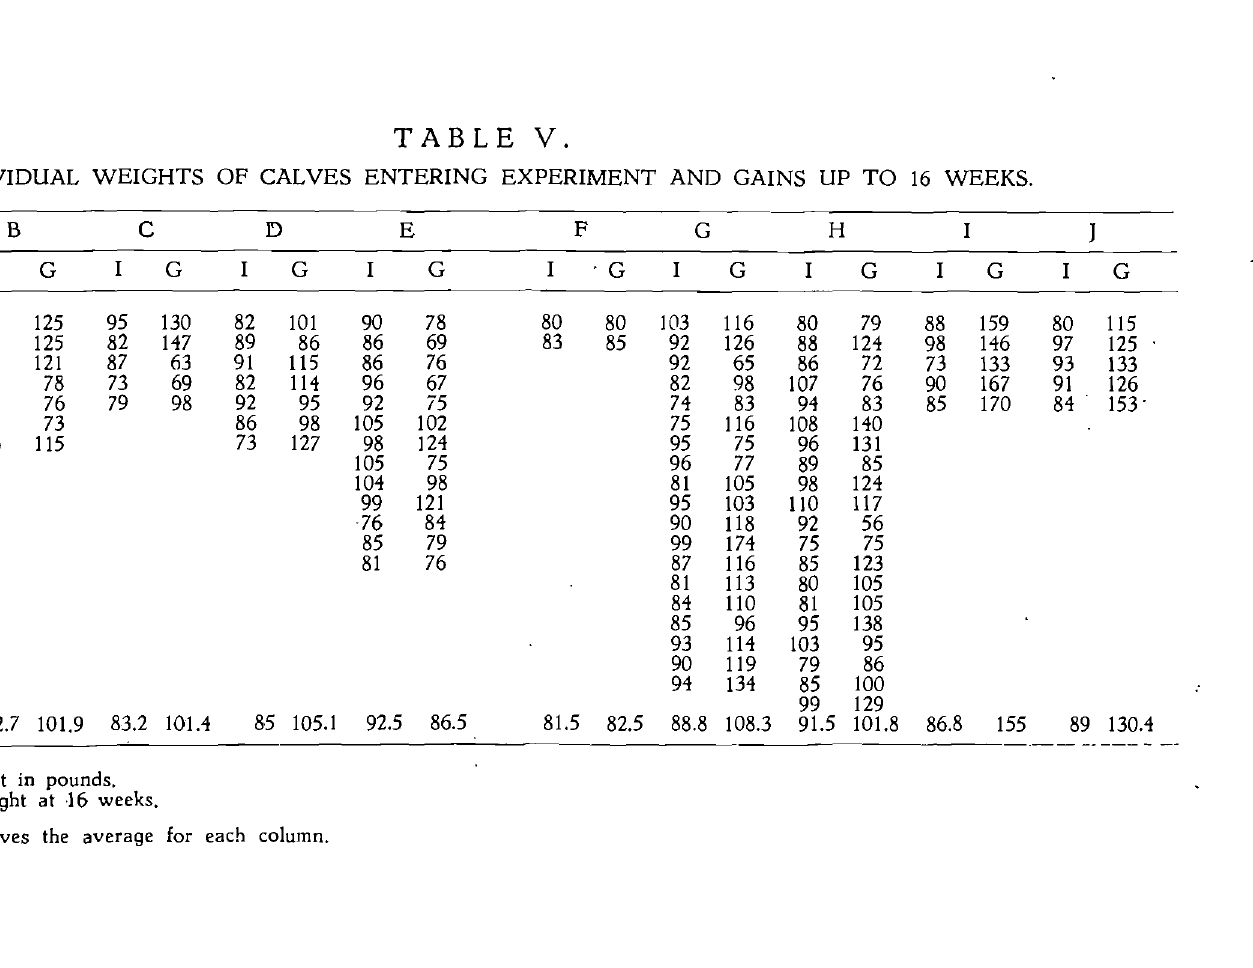
INDIVIDUAL WEIGHTS OF CALVES ENTERING EXPERIMENT AND GAINS UP TO 16 WEEKS.